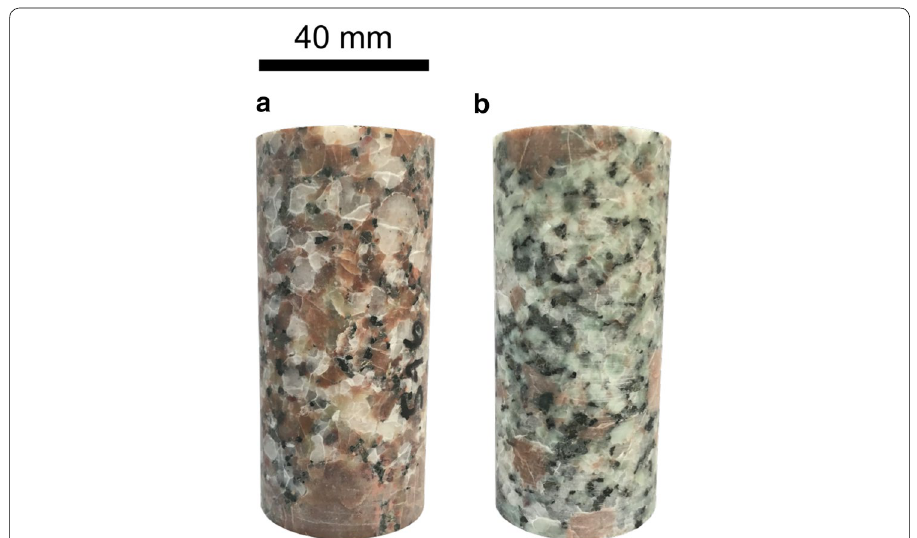
Fig. 2 Photographs of representative samples taken from EPS-1 (Soultz-sous-Forêts) geothermal borehole. All samples were re-cored to a diameter of 40 mm. All samples are from the uppermost (facies 1; see text for details) standard porphyritic granite. a An example of a sample of standard porphyritic granite from the palaeo-weathered zone. b An example of a sample of standard porphyritic granite (from below the palaeo-weathered